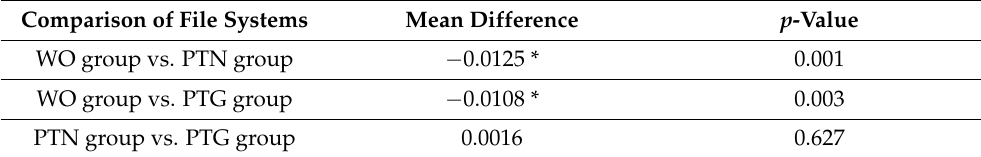
Table 3. Post hoc pairwise comparison of debris weight (LSD). Comparison of File